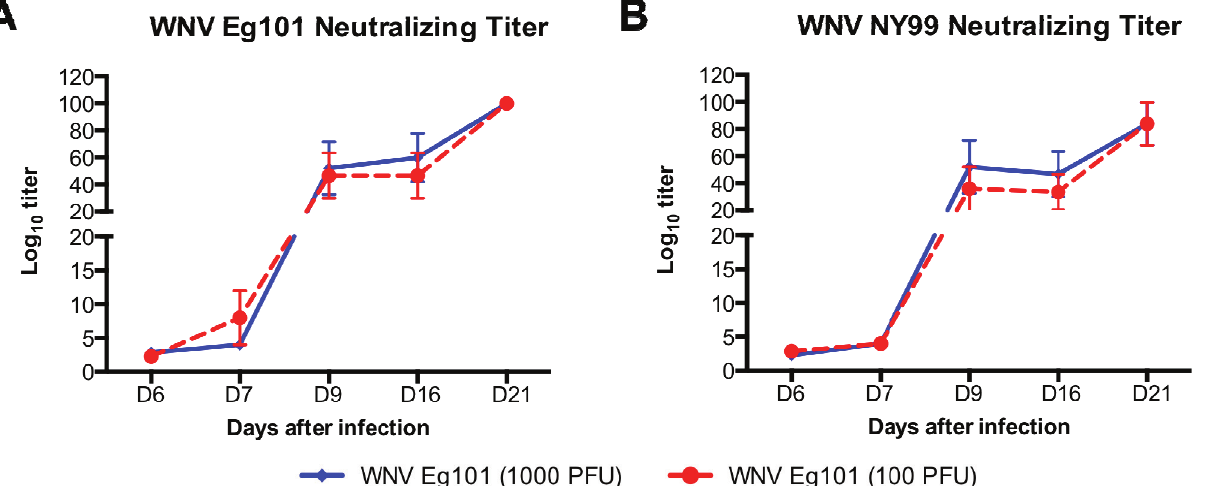
Figure 4. Neutralizing antibodies titers in the serum of WNV Eg101 infected mice. Serum collected from WNV Eg101 infected mice at indicated time points was serially